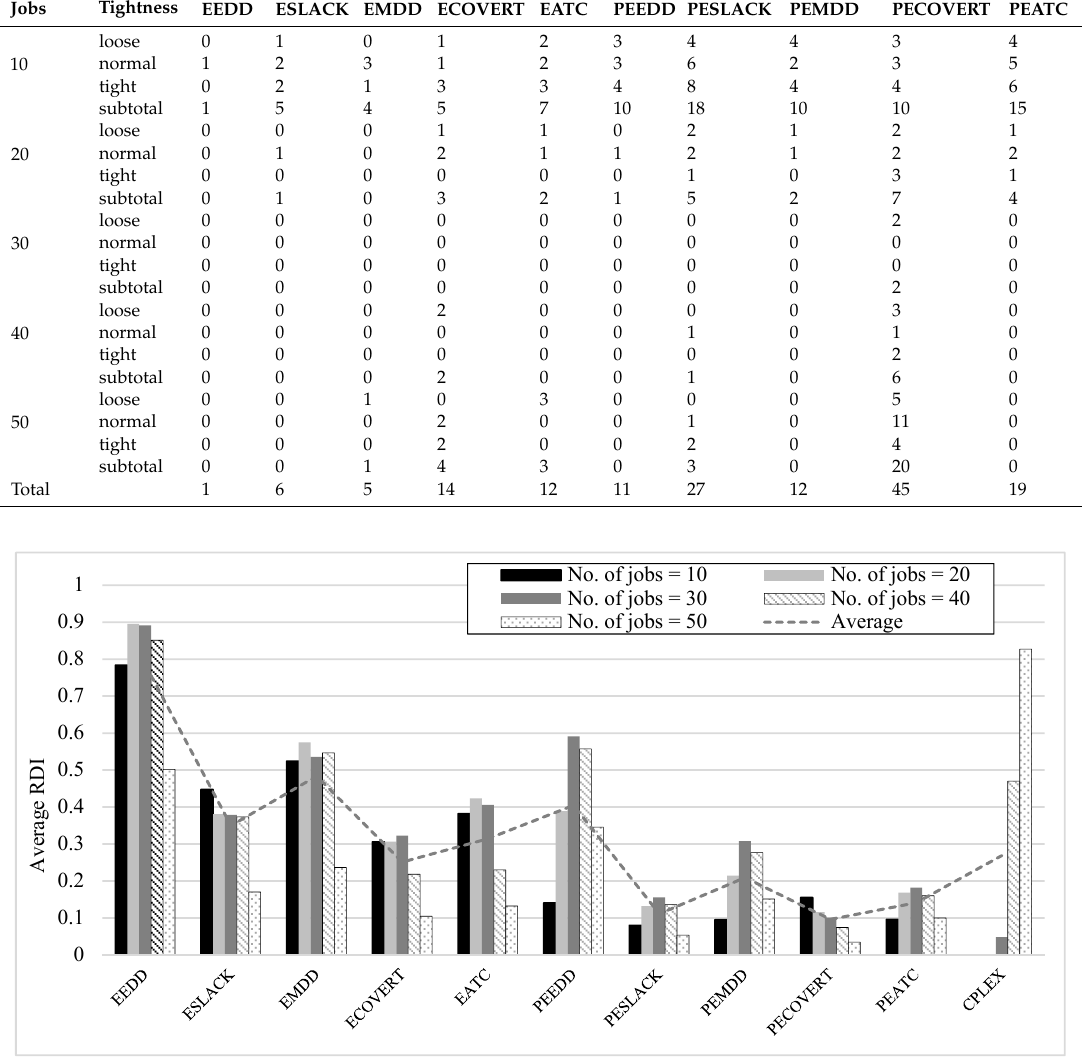
Figure 2. The average relative deviation index values of extended dispatching rules and their probabilistic ones. Table 5. Results of the Wilcoxon signed rank test.